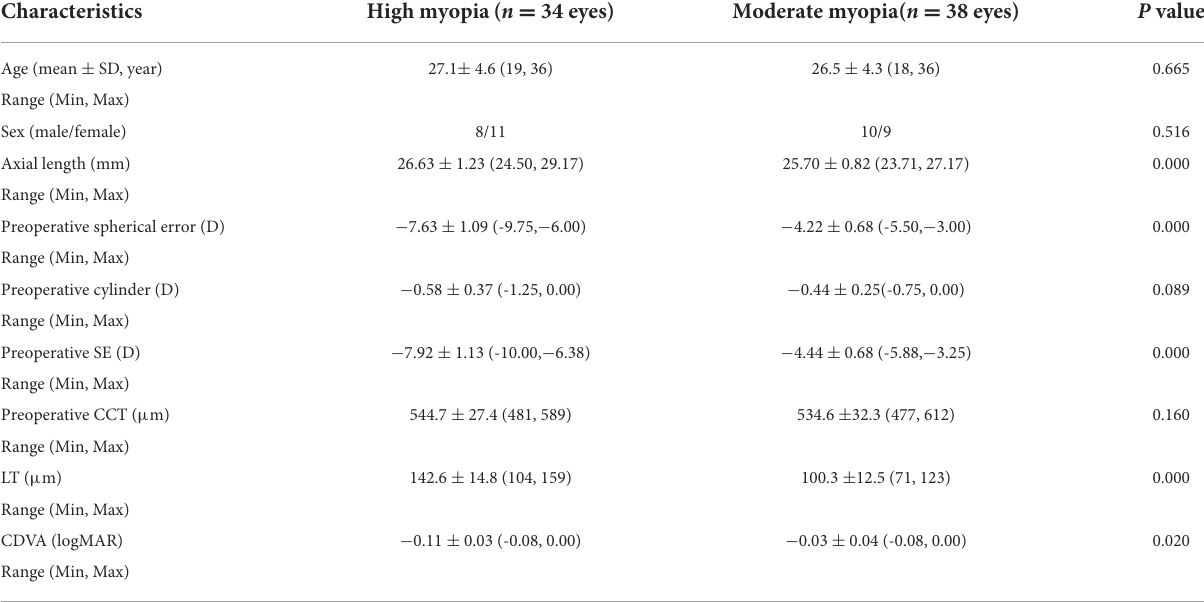
TABLE 1 Demographics, preoperative and surgery data of high myopia vs. Moderate myopia groups.